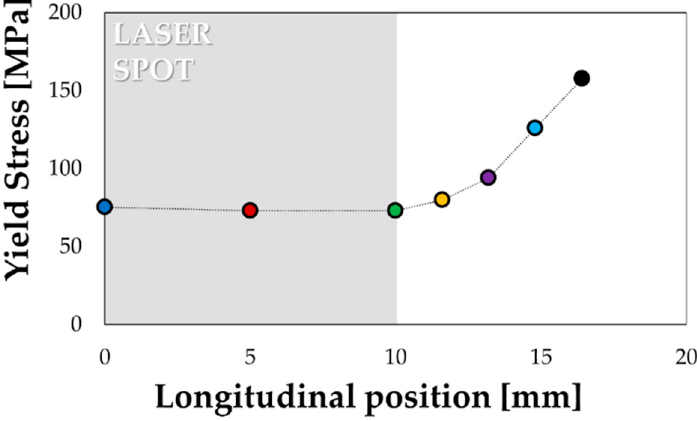
Figure 11. Distribution of the material yield stress along the specimen longitudinal axis.